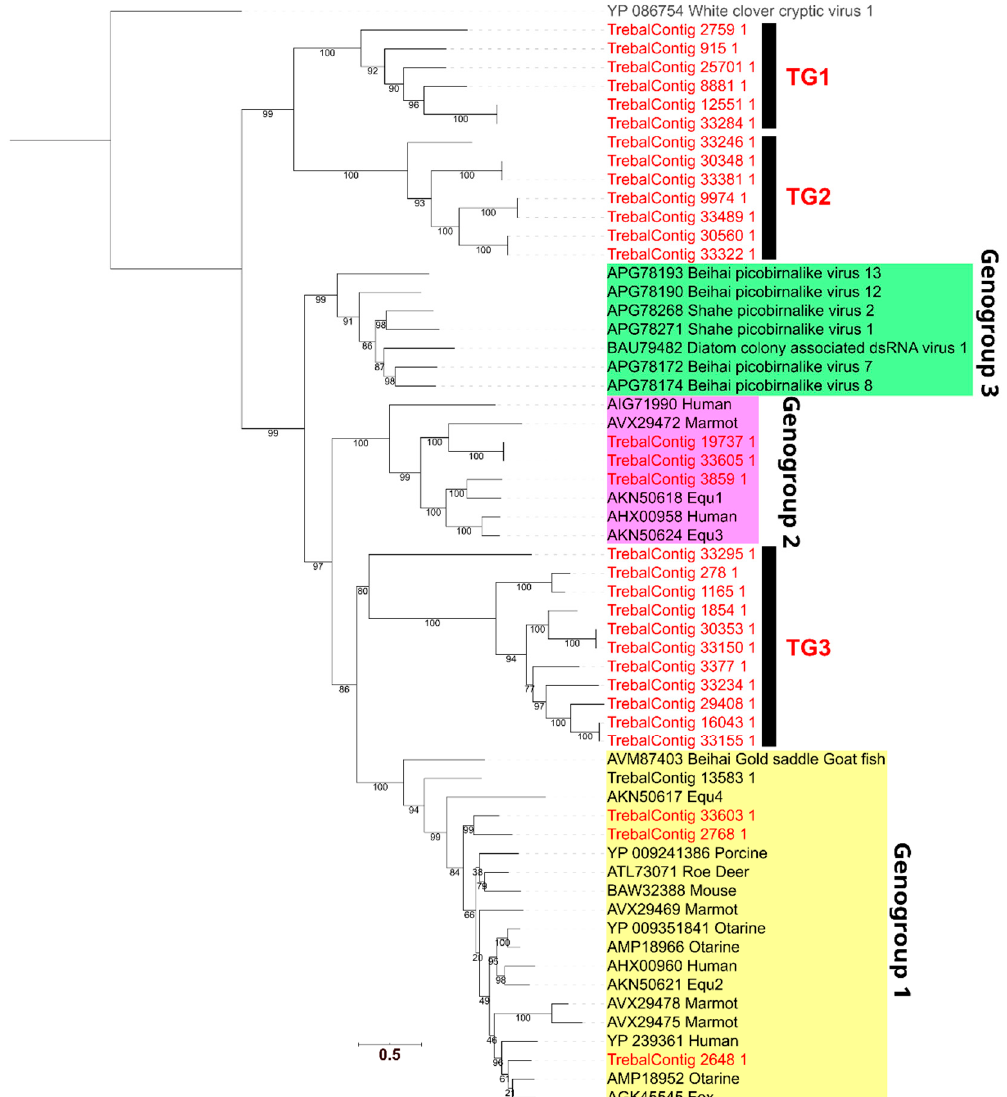
Figure 4. Maximum Likelihood phylogenetic reconstruction of 31 RNA-dependent RNA polymerase (RdRP) predicted proteins from Picobirnaviridae family. Node numbers indicate ultra-fast bootstrap values. RdRP sequence of White clover cryptic virus 1 was used as an outgroup and appeared in grey letters. The sequences characterized in the present study are reported in red letters. Scale bar: 0.5 aminoacid substitution per site.